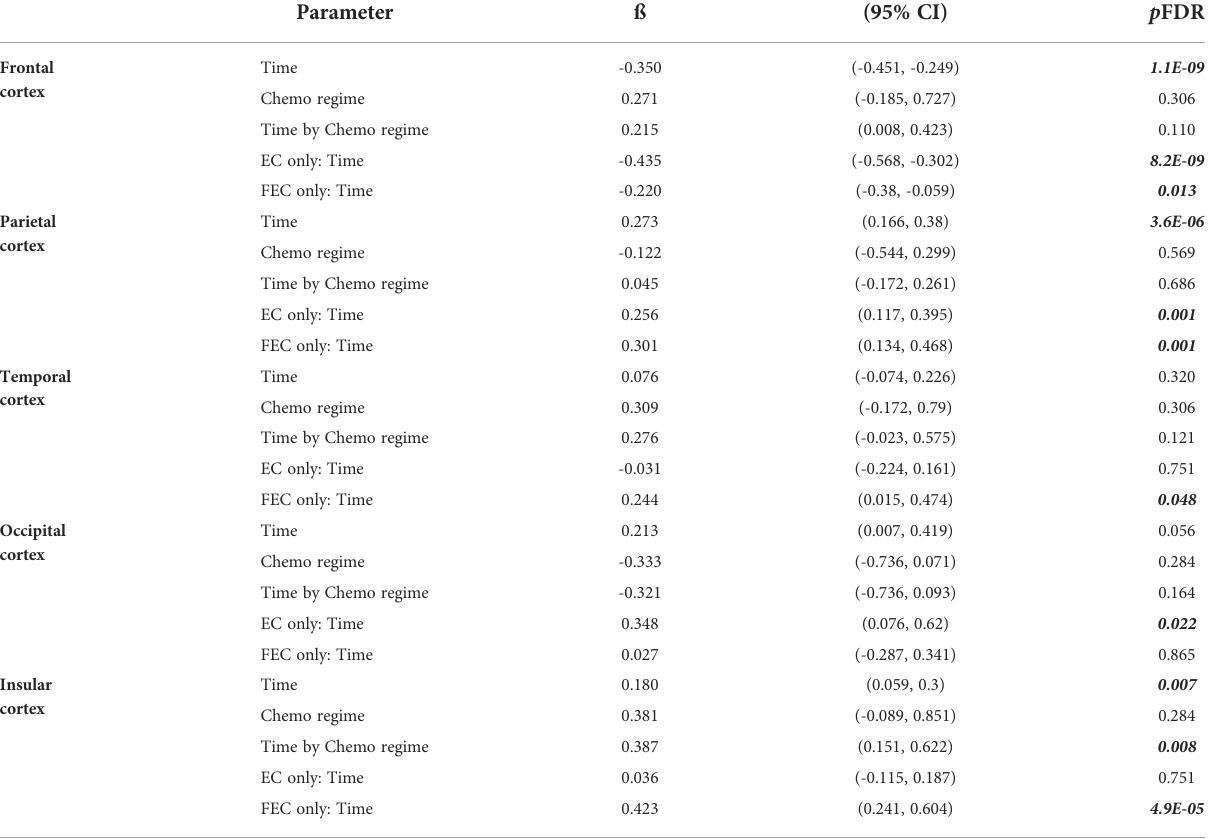
TABLE 2 Robust mixed-effects modelling of time and treatment effects on relative brain glucose